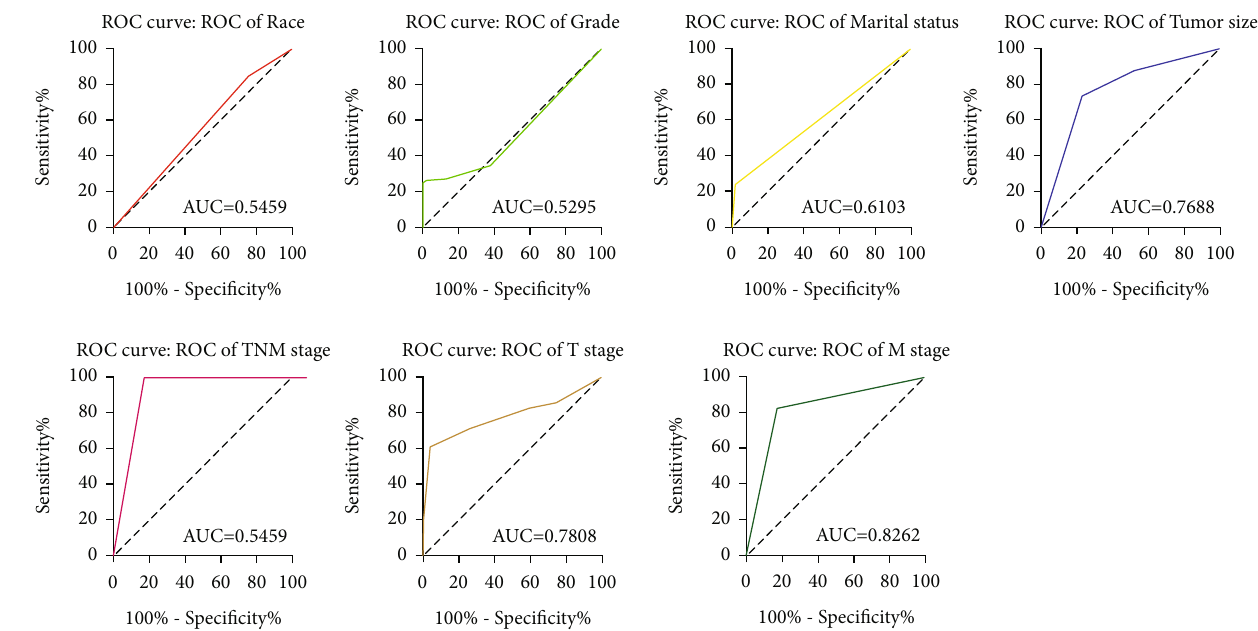
Figure 2: Race, grade, marital status, tumor size, TNM stage, T stage, and M stage to evaluate ROC curve of gastric cancer bone